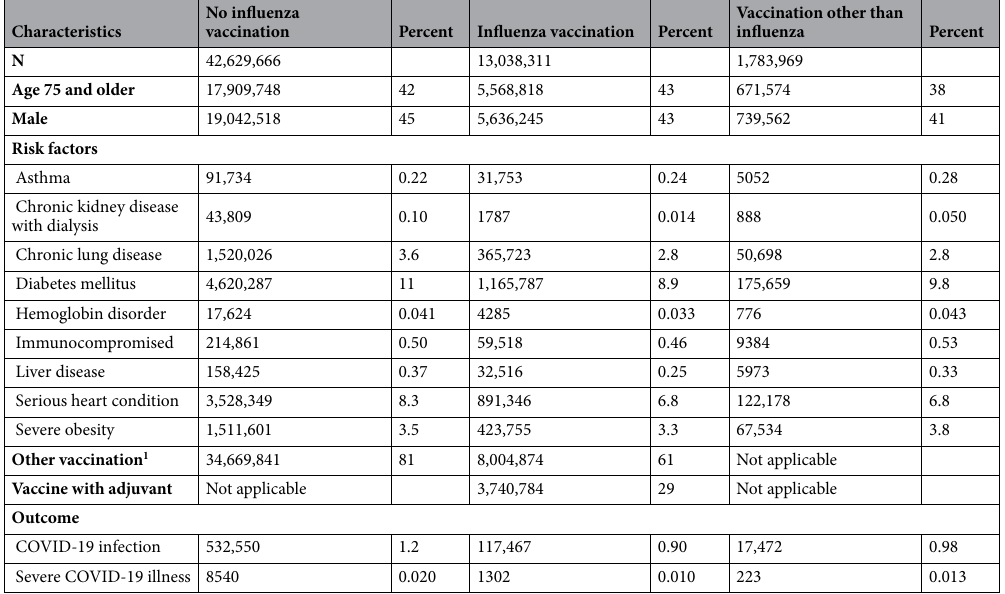
Table 1. Characteristics of the three study cohorts: no influenza vaccination, influenza vaccination, and vaccination other than influenza. 1 Other vaccines: herpes zoster, pneumococcal pneumonia, tetanus, and hepatitis